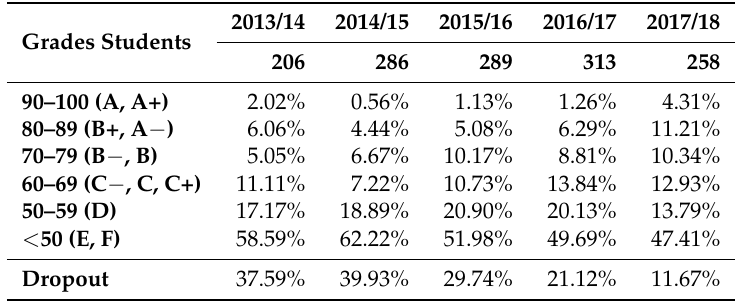
Table 4. Students